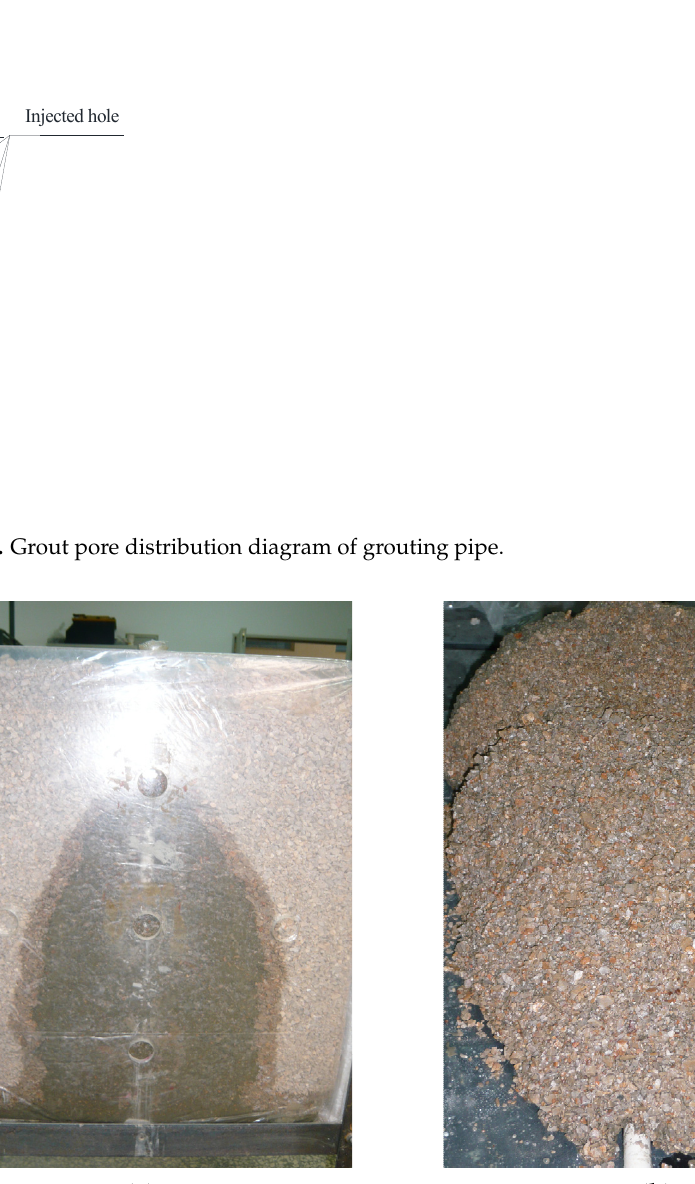
Figure 6. Photographs of grouting experimental process. ( a ) Permeation and diffusion form of Newtonian cement slurry in the gravel sand; ( b ) the grouted stone body.